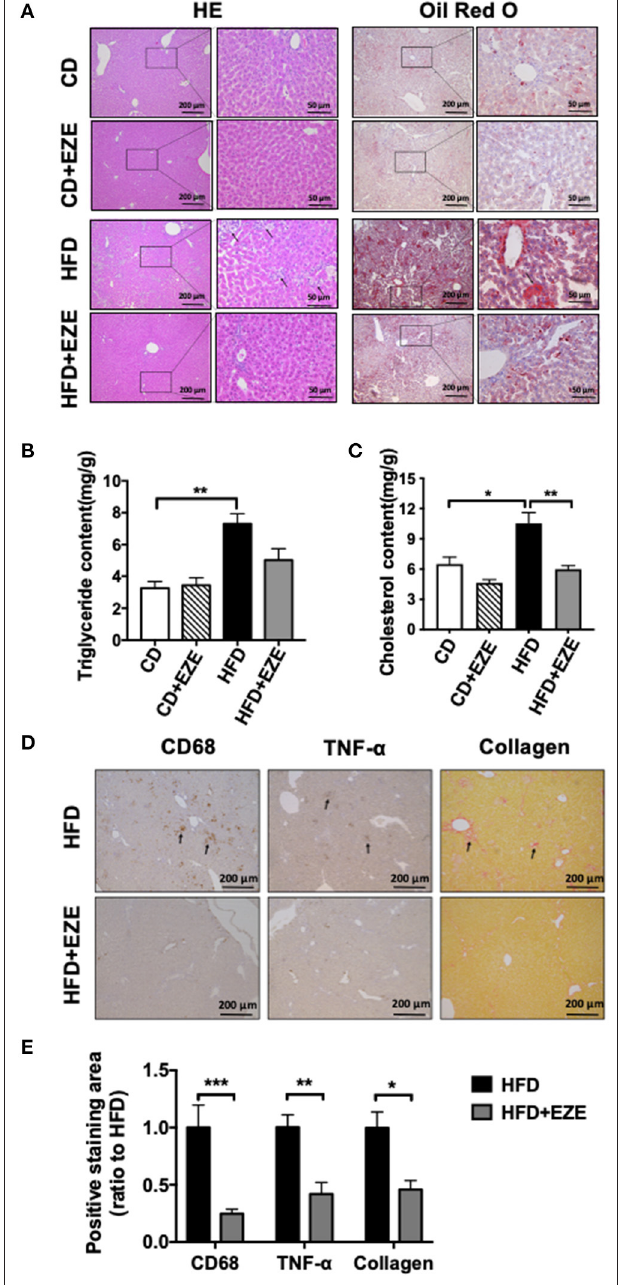
FIGURE 4 | Hepatic morphological analysis and lipid extraction. LDLR − / − hamsters were fed CD or HFD for 40 days and administrated with ezetimibe ( + EZE) or solvent. (A) Representative images of liver cross-sections with H&E and oil red O staining. Scale bar = 200 or 50 µ m, respectively. (B) Hepatic triglyceride content ( n = 5), and (C) hepatic cholesterol content ( n = 5). (D) Representative immunohistochemistry stained images of CD68 and TNF- α , and sirius red-stained images and (E) the relative quantization. Scale bar = 200 µ m. Data are shown as mean ± SEM. Two-way ANOVA with Tukey’s multiple comparison test, * p < 0.05, ** p < 0.01, *** p <